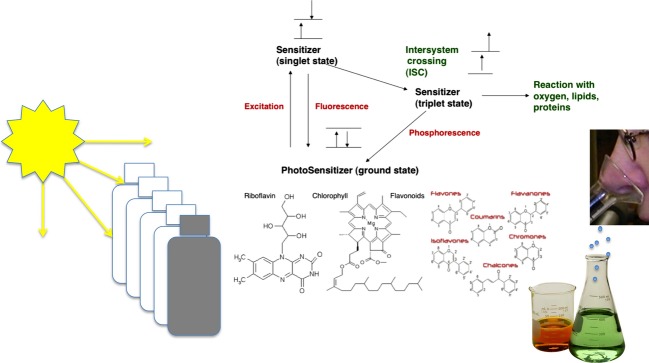
Integration of polymer chemistry, photochemistry, volatile chemistry, and sensory analyses provides packaging design guidance.